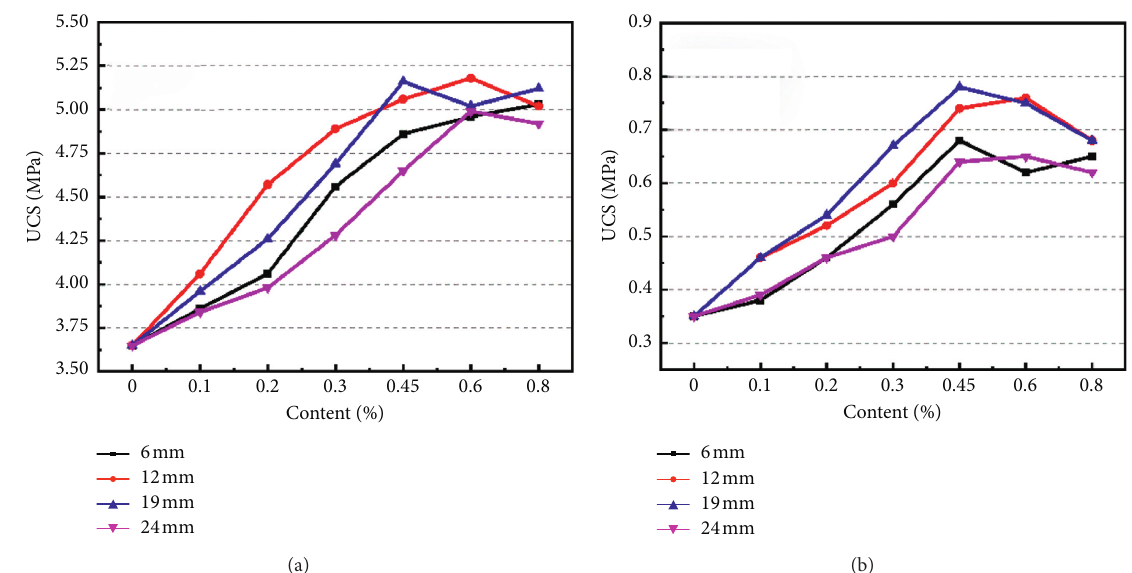
Figure 8: UCS and STS test results of fiber-reinforced soil. (a) UCS. (b)